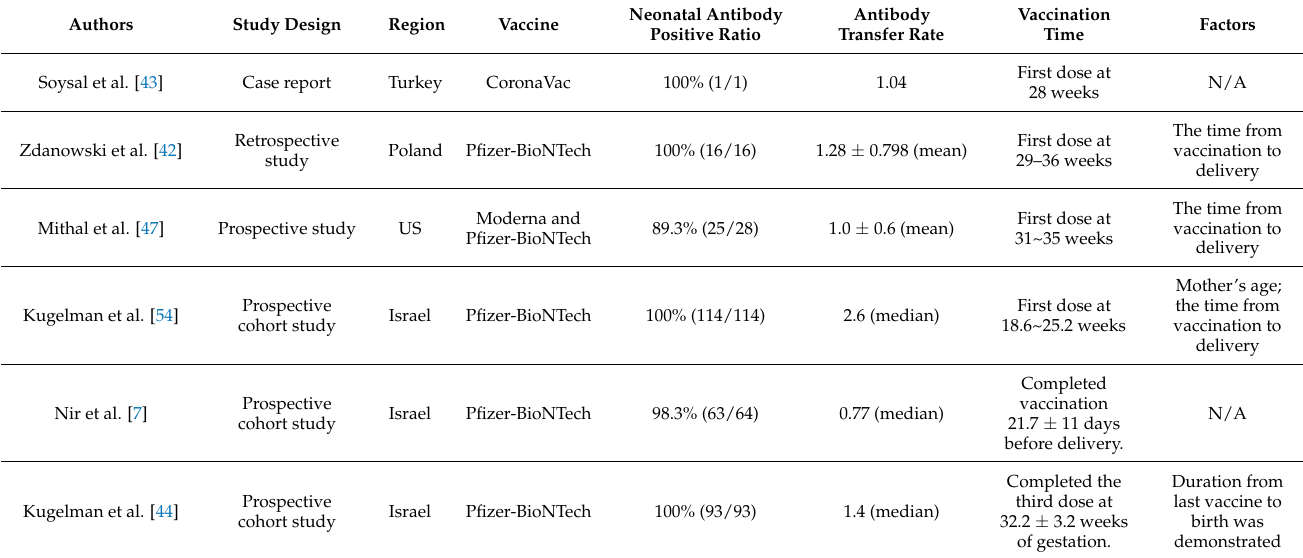
Table 2. Summary of several studies on maternal antibodies in pregnant women and fetuses after the coronavirus disease 2019 (COVID-19)